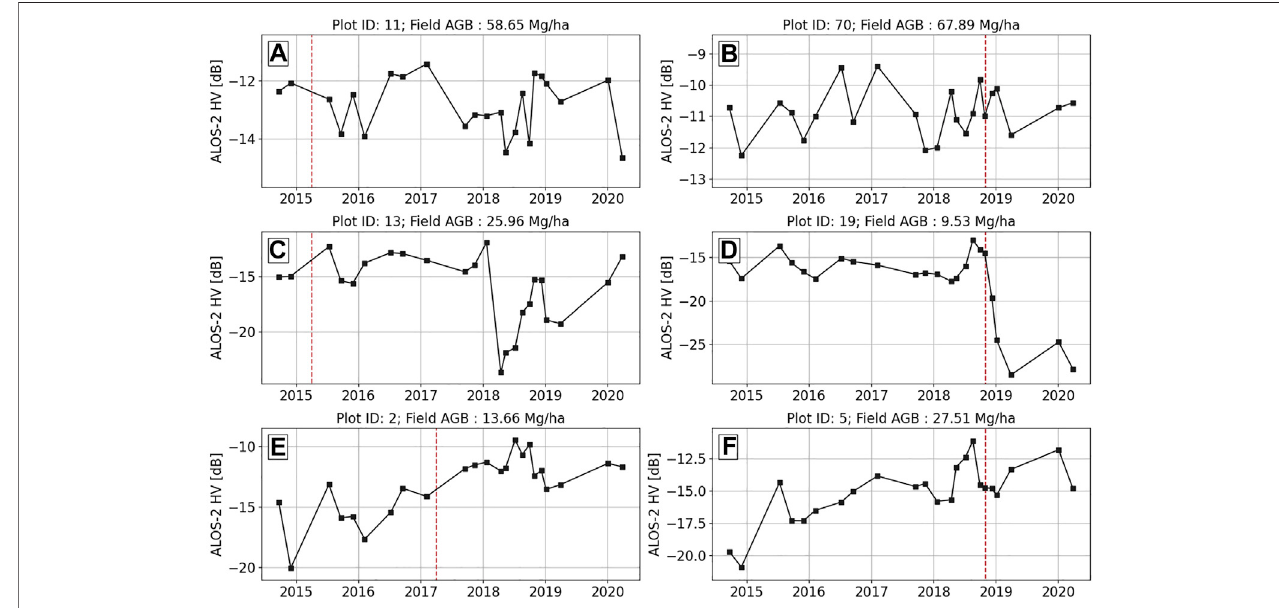
FIGURE4| HV-polbackscattertime seriesof fi eldplotsrepresentingstableforests (A) and (B) ;clear-cutforests (C) and (D) ;andgrowthinforests (E) and (F) .The red dashed line represents the date of fi eld campaign for each plot. The plot ID and the AGB measured during the fi eld campaign are annotated.